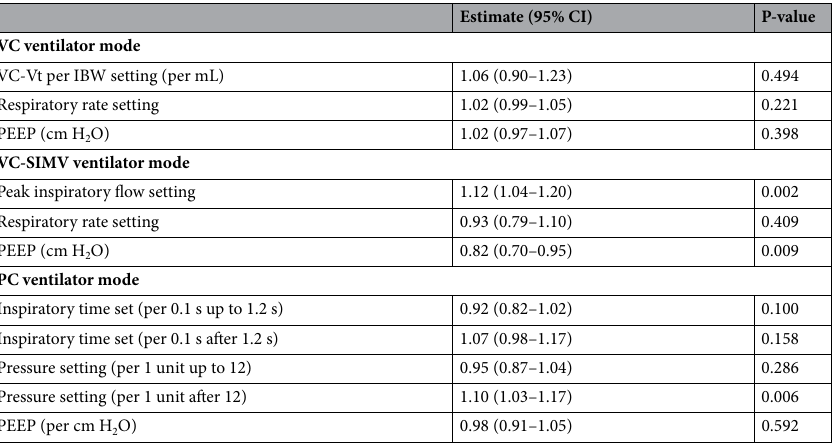
Table 3. Association of overall PVA with ventilator settings during different ventilator mode using PWP-GT model. PWP-GT model: Prentice, Williams, and Peterson gap time. As there were different settings in different modes, we did 3 analyses limited to 3 ventilation modes due to rare frequency of PC-SIMV ventilation, including among the 3 analysis a total 666 patients underwent 686 episodes of mechanical ventilation. Models were fit using data from patients with the given ventilator delivery type (mode) at any point during their episode of mechanical ventilation, with only the time under that delivery mode contributing to the given analysis. All models were adjusted for age, sex, and ideal body weight, history of smoking, heart disease, chronic lung disease, kidney disease, immunosuppression, neurologic disease, cirrhosis, and reason for initiation of mechanical ventilation. In addition to the baseline covariables listed, each model included the mode-specific settings as time-dependent covariables. Robust sandwich variance estimates were used to account for the potential within patient correlation. For each model, the terms were assessed for collinearity and functional form. When evidence of non-linearity was found, the piecewise linear spline was chosen for ease of interpretation. Other notes: Each model was stratified by number of prior asynchrony events. Multiple events were allowed and start/stop times were re-started after a change in ventilator mode or an asynchrony event.